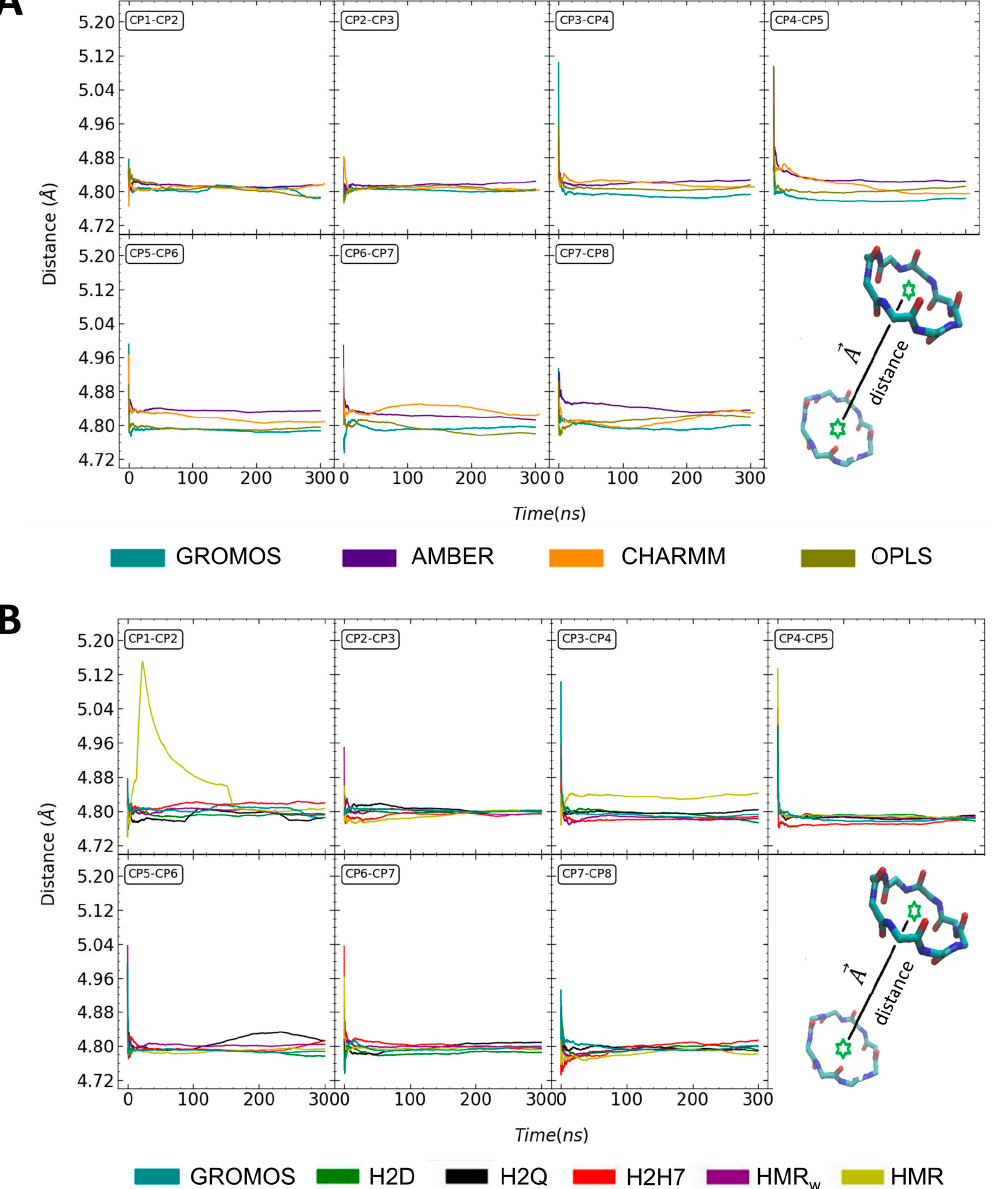
Figure 5. Evolution of the c.o.m. distance (in Å) between pairs of CPs along the trajectory, for the unmodified force fields ( A ), and for the modified parameterizations of GROMOS ( B ). Each color corresponds to a different force field, according to the legends.